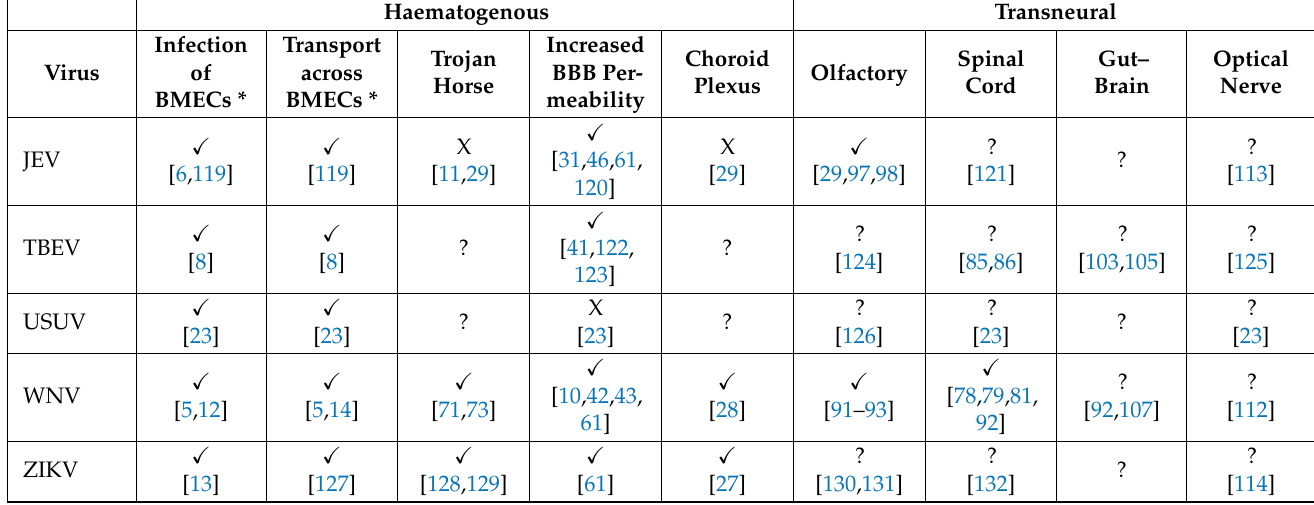
BBB = blood–brain barrier. BMEC = brain-microvascular endothelial cell. JEV = Japanese encephalitis virus. TBEV = tick-borne encephalitis virus. USUV = Usutu virus. WNV = West Nile virus. ZIKV = Zika